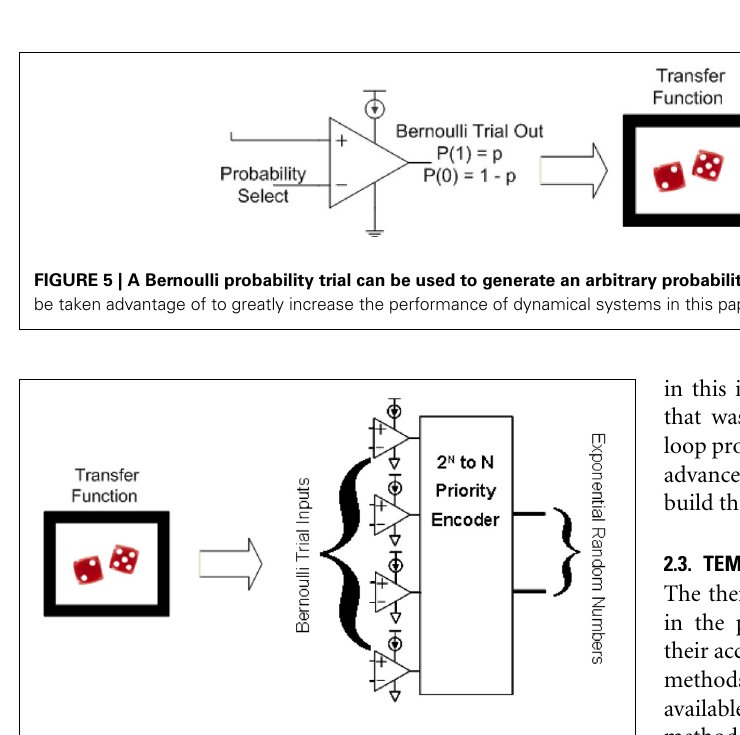
FIGURE 6 | Illustration of how to transform N Bernoulli trials into an exponential distribution. Bernoulli trials put through a priority encoder as inputs results in an exponentially distributed probability function, where the shape of the exponential function can be tuned through the threshold inputs to the Bernoulli